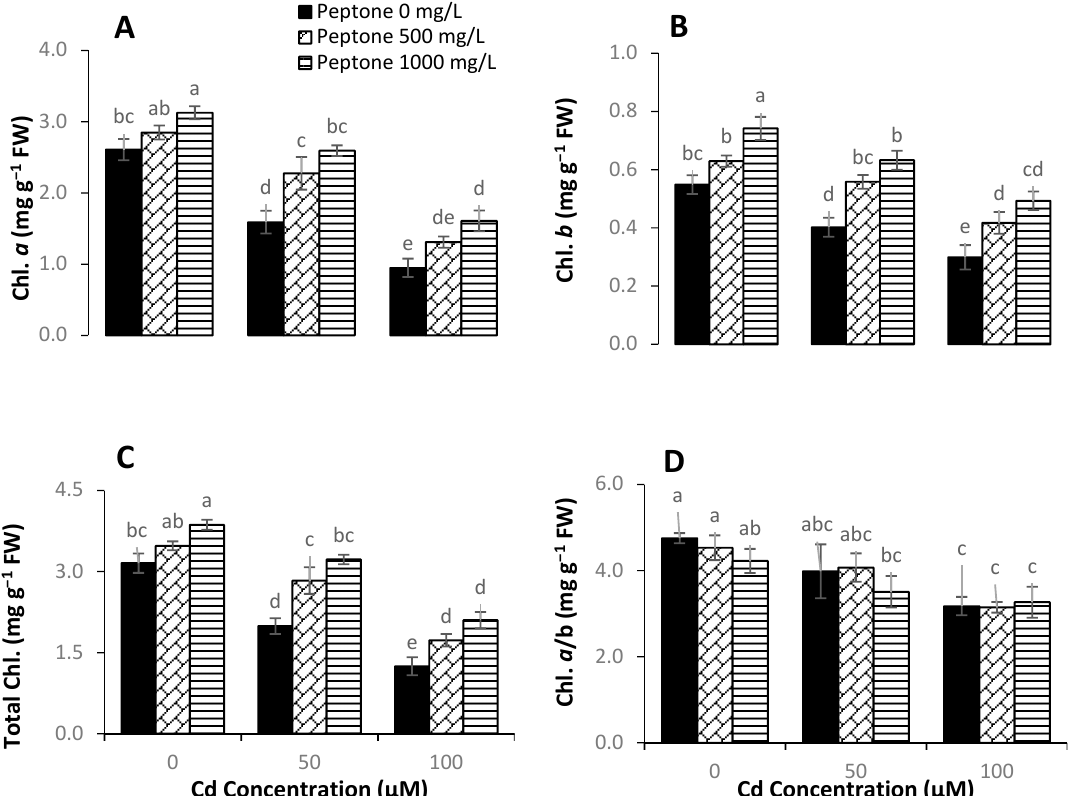
Figure 2. The influence of the foliar application of peptone (0, 500, and 1000 mgL − 1 ) on chlorophyll a ( A ), chlorophyll b ( B ), total chlorophyll ( C ), and chlorophyll a / b ratio ( D ) of spinach plants grown under Cd stress. Values represent the means of four replicates with standard deviations. Letters on the bar indicate the significant differences between given treatments at p < 0.05.